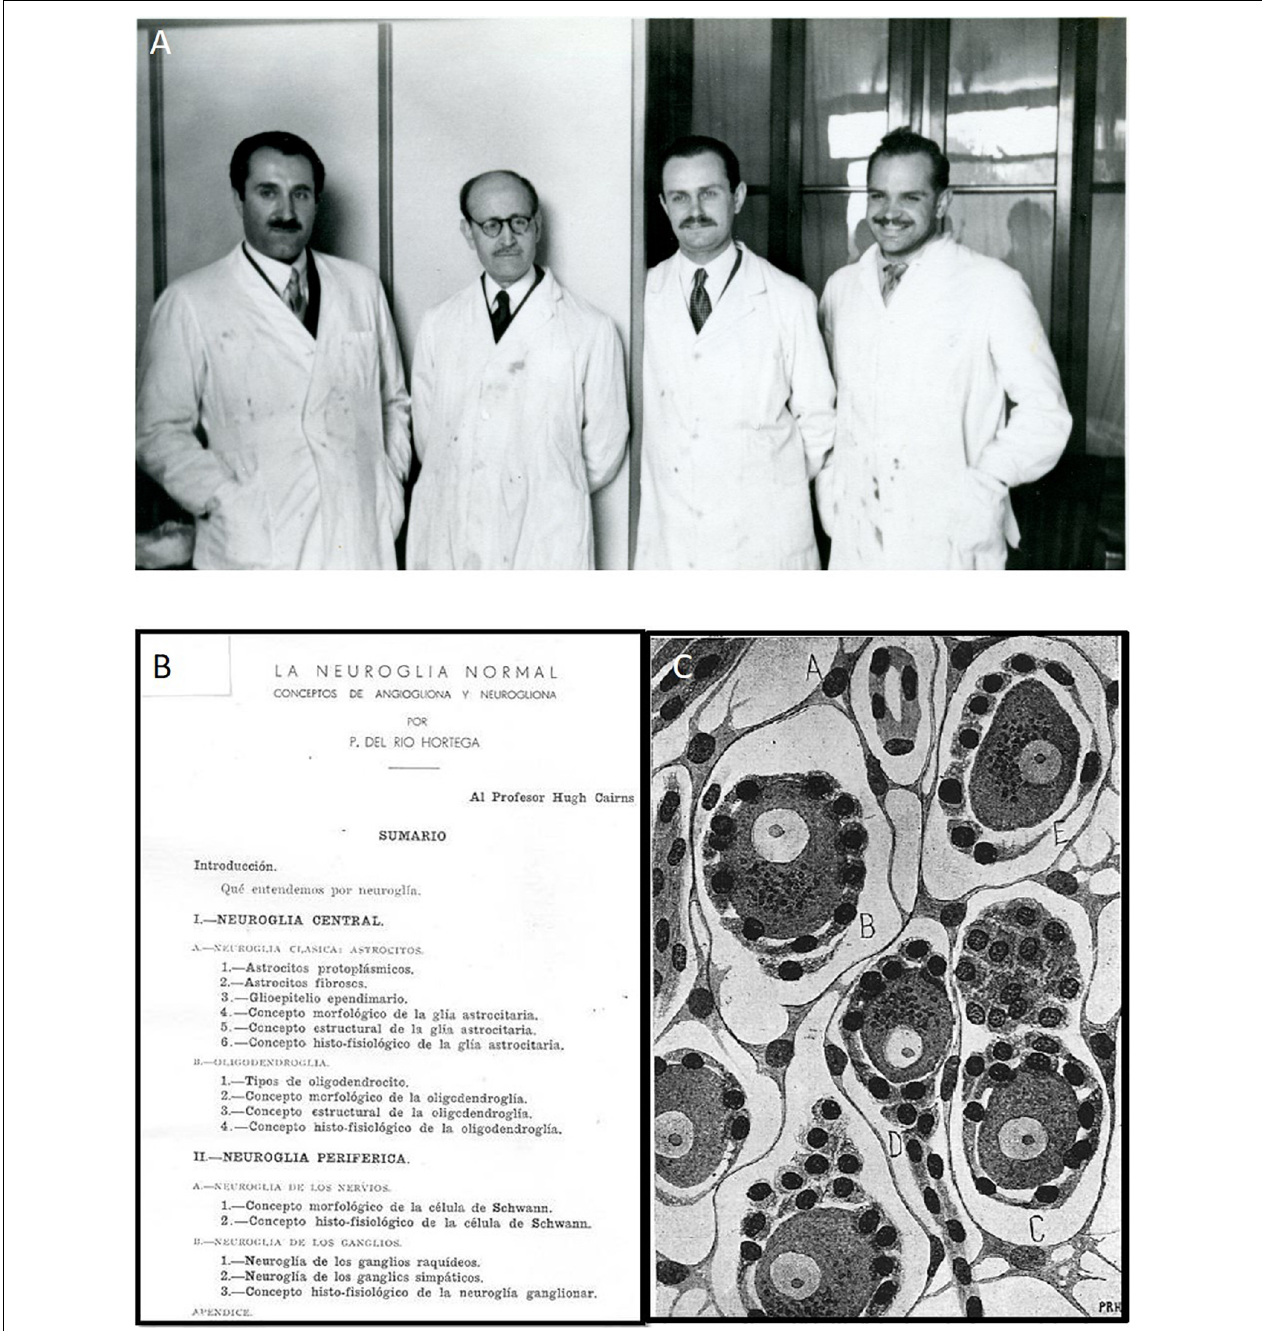
FIGURE 3 | Pío del Río-Hortega in Argentina. (A) From the left to the right, Prof. Washington Buño, Dr. Pío del Río-Hortega, Moisés Polak, and Dr. Crosso, in Buenos Aires. (B) Front page of Río-Hortega’s paper entitled “The normal neuroglia. Concepts of ‘angiogliona’ and ‘neurogliona,”’ published in 1942 in honor of Hugh (del Río-Hortega, 1942). (C) Glial cells ( A , C ) and sensitive neurons ( B , D , E ) from the sensitive ganglia (del Río-Hortega et al., 1942). See on the bottom right corner one of the rare signatures of Pío del Río-Hortega in his original drawings (as: